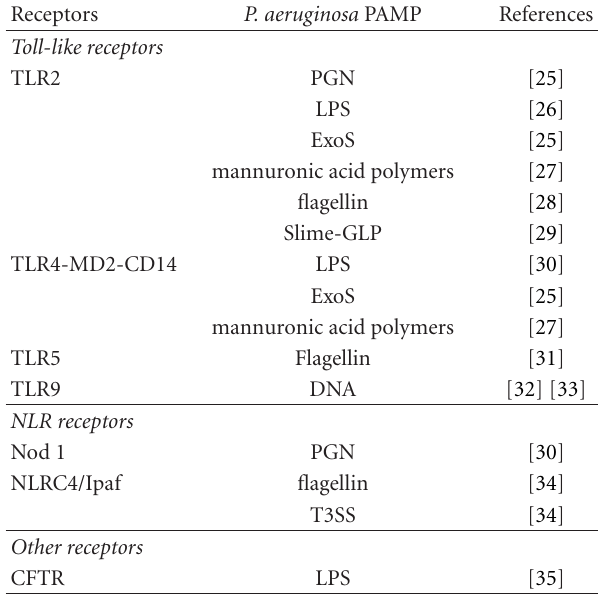
Table 1: PRRs sensing P. aeruginosa -associated molecular patterns.